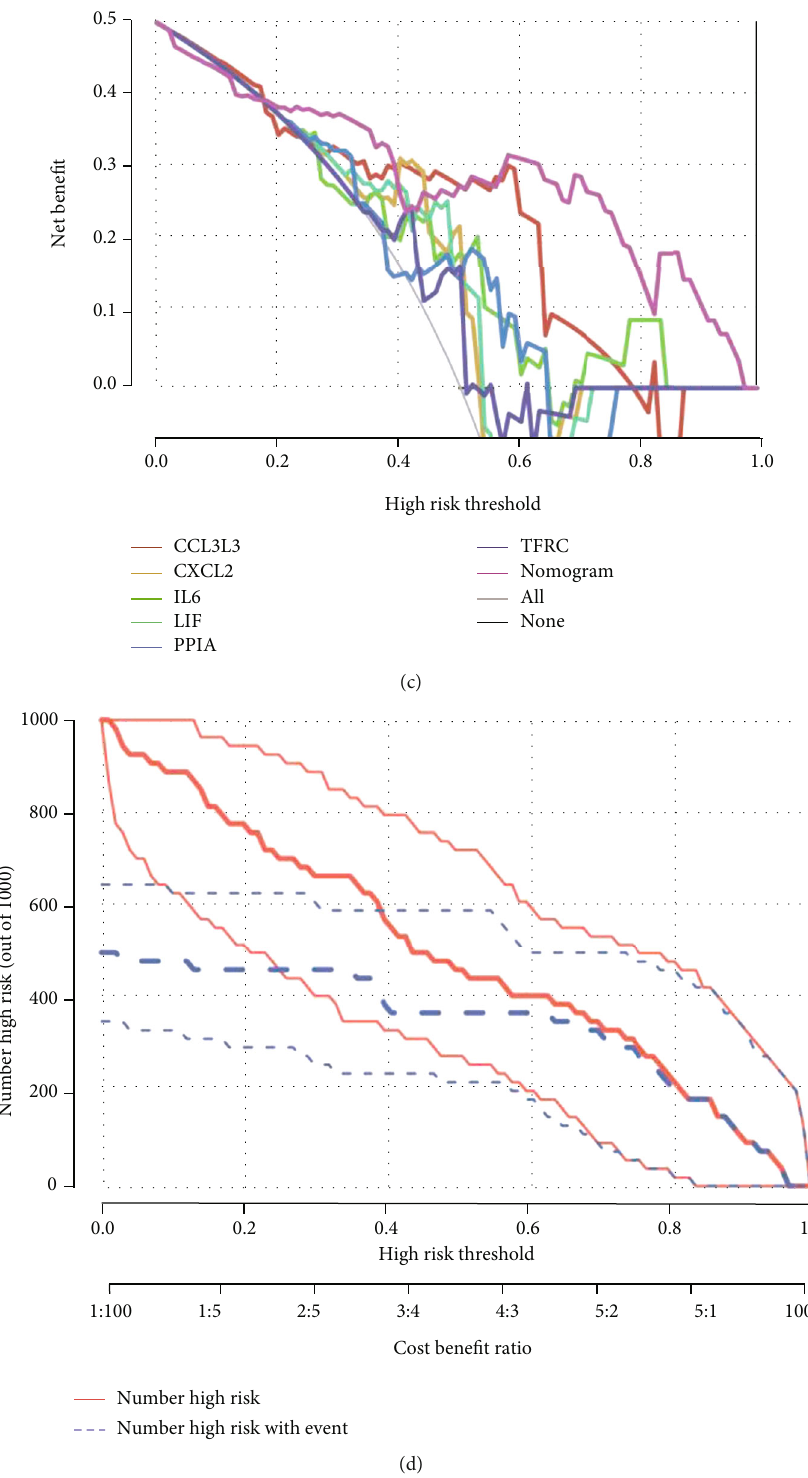
Figure 4: Construction and validation of a nomogram model for IgAN diagnosis. (a) Nomogram model for IgAN diagnosis, based on the 6 DIRGs (PPIA, CCL3L3, CXCL2, TFRC, IL6, and LIF). (b) Calibration curve to evaluate the nomogram model. The actual IgAN risk and the predicted risk are very close. (c) DCA curve to assess the nomogram model. Di ff erent colors represent di ff erent combinations of variables, and the nomogram model has better bene fi ts than other models in most risk thresholds. (d) The clinical impact curve based on the DCA curve to evaluate the nomogram model, and the nomogram model has a better clinical e ff ect when the risk threshold exceeded